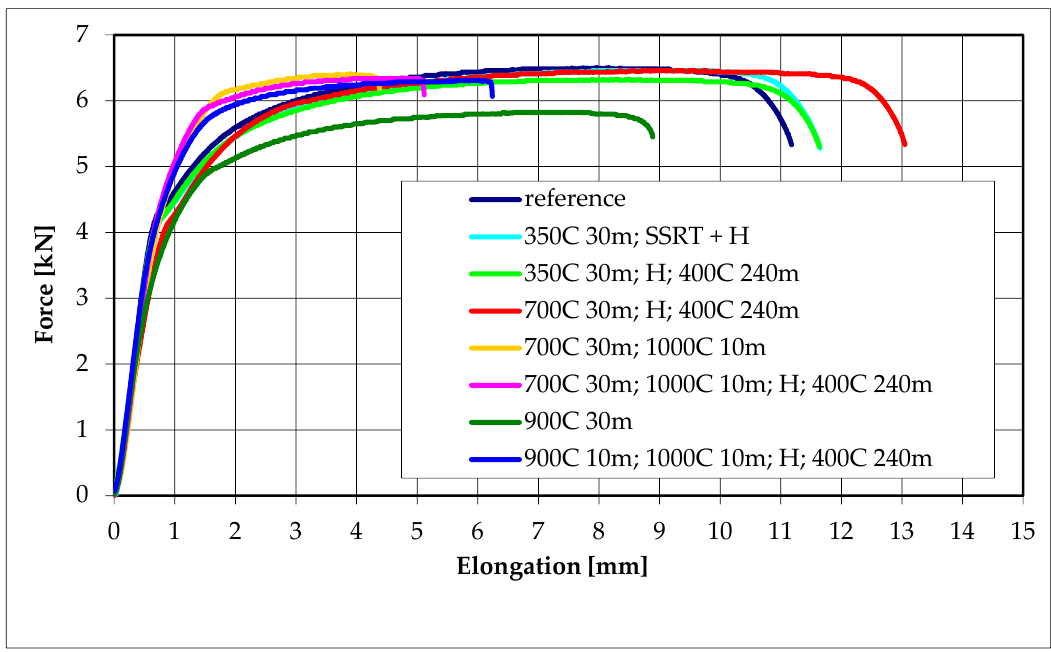
Figure 11. Stress–strain relationships for specimens oxidized at di ff erent temperatures of 350 ◦ C, 700 ◦ C and 900 ◦ C followed by oxidation at 1000 ◦ C for 10 min, either hydrogen charged during slow strain rate test or hydrogen charged at a constant current density of 80 mA / cm 2 , homogenized at 400 ◦ C for 4 h and then tensed.